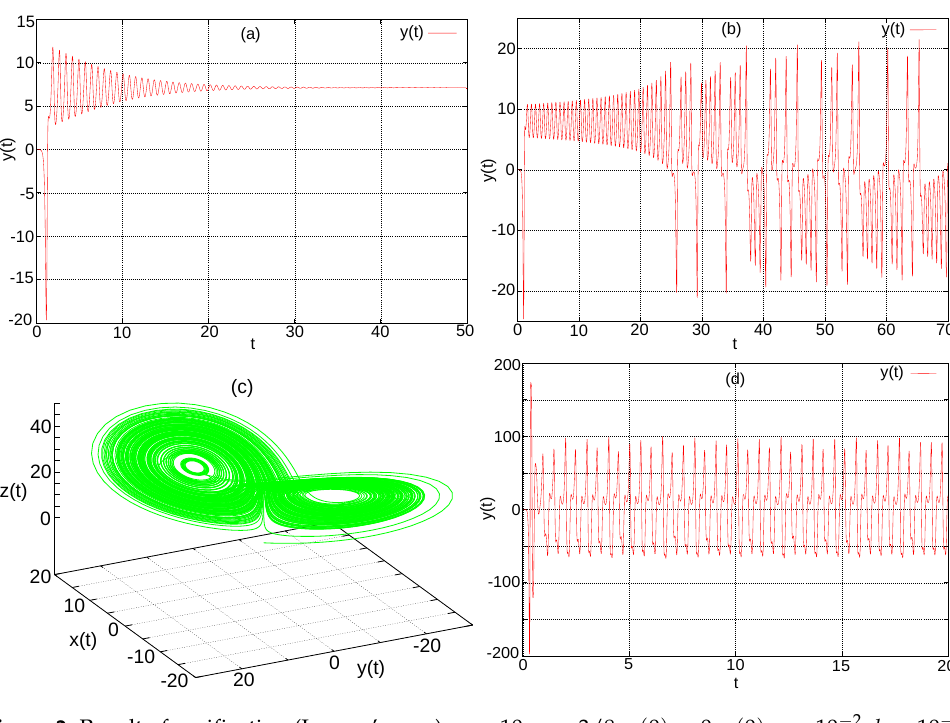
Figure 2. Result of verification (Lorenz’s case): µ = 10, p = 3/8, x ( 0 ) = 0, y ( 0 ) = − 10 − 2 , h = 10 − 2 . ( a ) D = 25—asymptotically stationary regime; ( b ) D = 25—chaotic regime; ( c ) D = 28—chaotic attractor; ( d ) D = 210—quasi-periodic